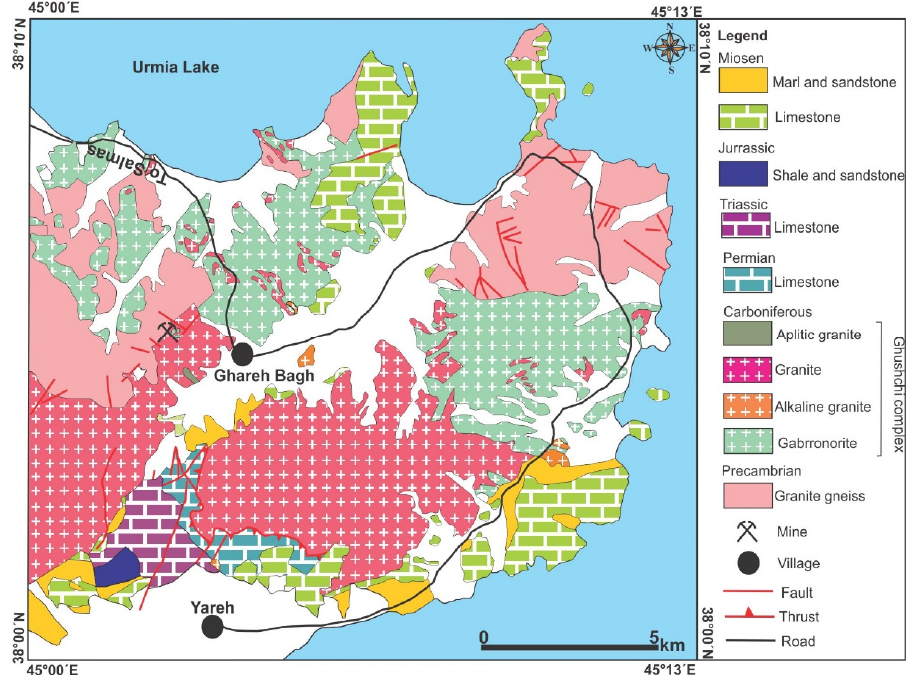
Figure 2. Geological map of the study area [41]. The Ghareh Bagh mine is situated at the contact of Ghushchi alkali granite and Ediacaran metamorphic rocks.